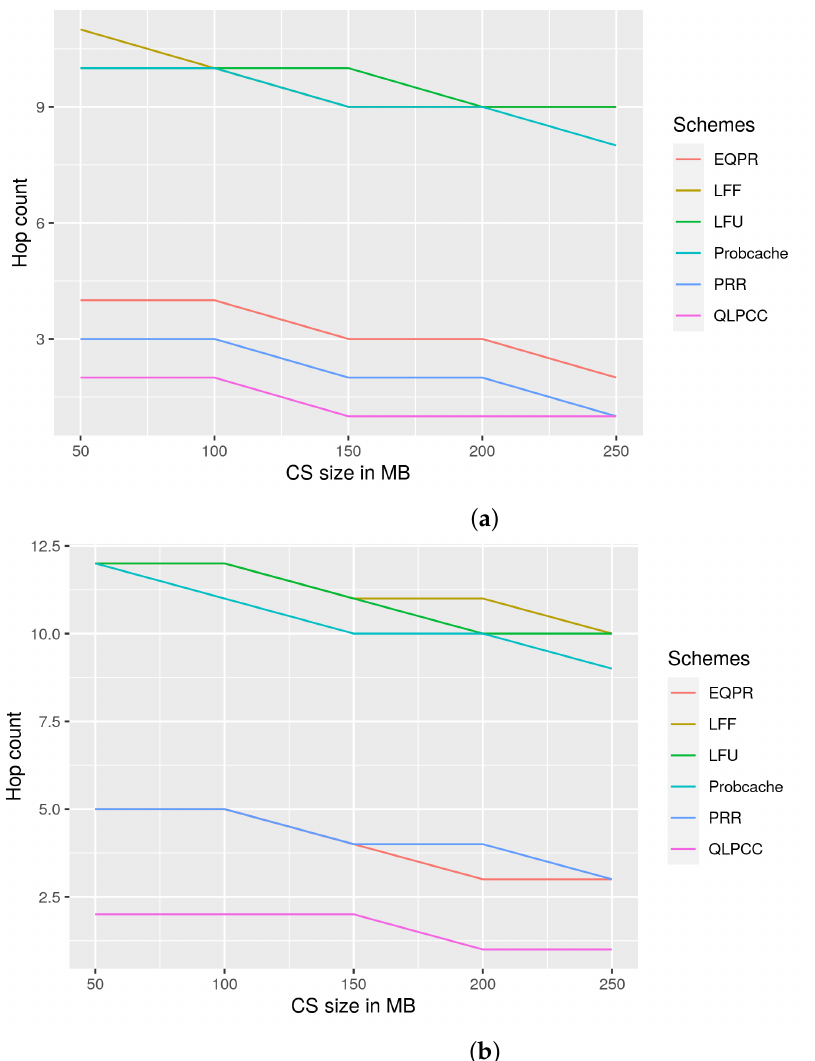
Figure 9. Hop count vs. content store size for QoS traffic. ( a ) Hop count vs. content store size (QoS traffic) for | M | = 500. ( b ) Hop count vs. content store size (QoS traffic) for | M | =